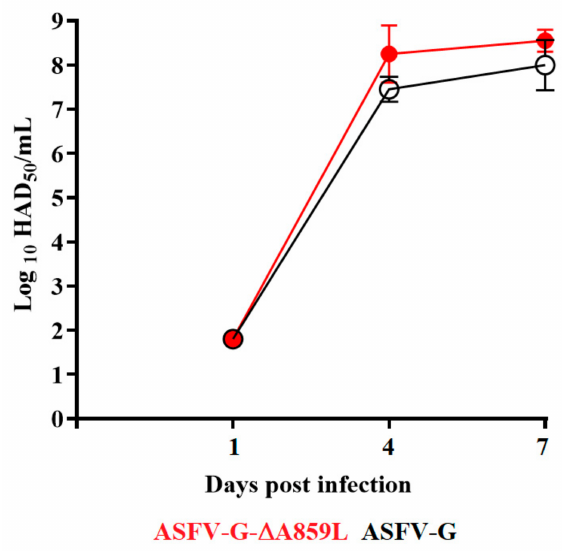
Figure 5. Viremia titers detected in pigs IM inoculated with 10 2 HAD 50 of either ASFV-G- ∆ A859L (filled symbols) or ASFV-G (empty symbols). Each symbol represents the average of animal titers in each of the groups. Sensitivity of virus detection: >log10 1.8 TCID 50 / mL . No significant differences in viremia values between both groups of pigs were found during the course of the experiment using the Holm–Sidak method ( α = 0.05). All calculations were conducted on the software GraphPad Prism version